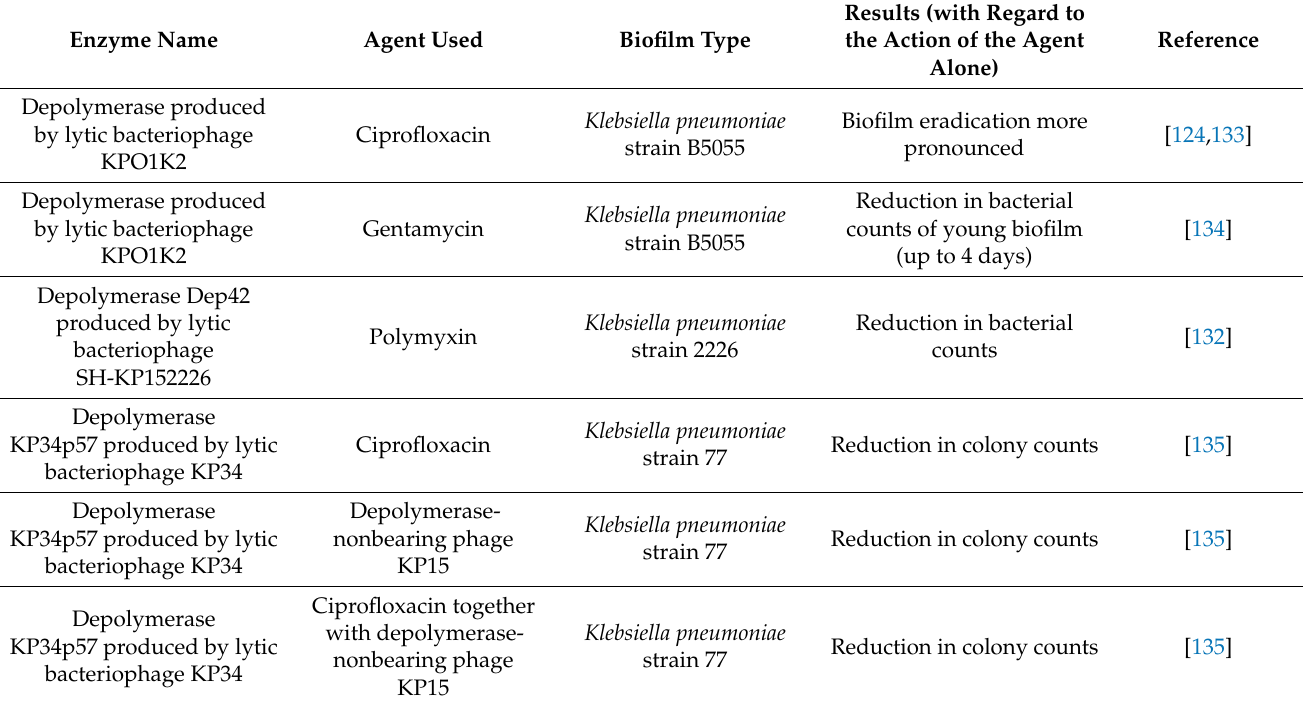
Table 1. Examples of the combined therapy against bacterial biofilm